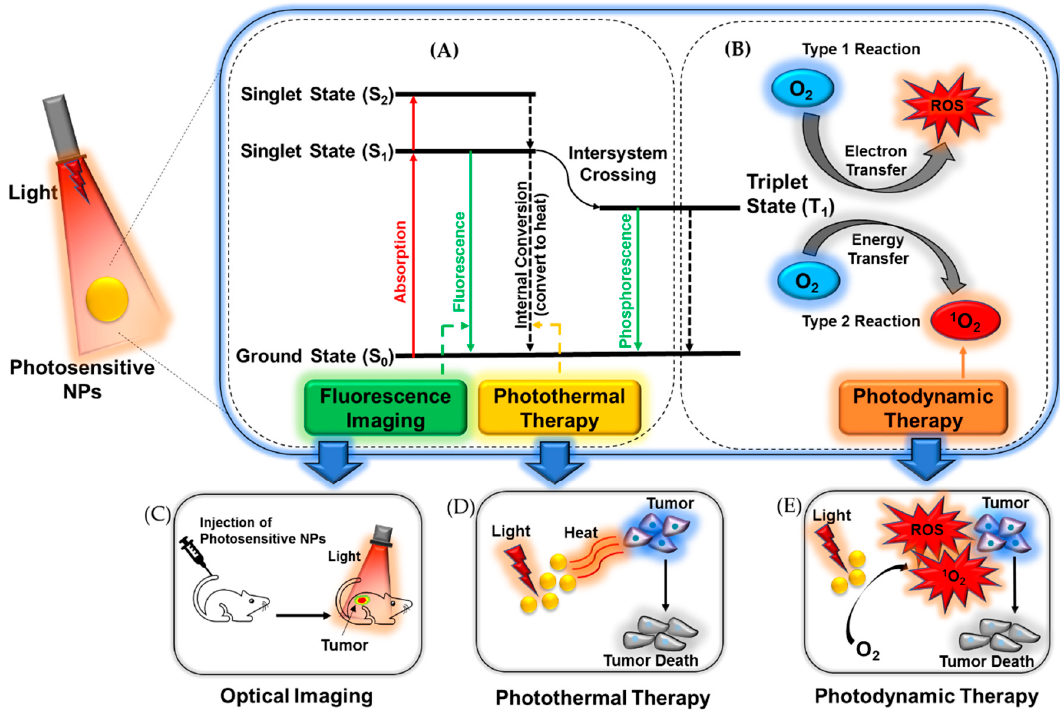
Figure 1. Illustration of the basic mechanism used in ( A ) fluorescence imaging and PTT, and ( B ) PDT and use of photosensitive nanomedicine in ( C ) OI, ( D ) PTT, and ( E ) PDT. NPs: nanoparticles; ROS: reactive oxygen species; PTT: photothermal therapy; PDT: photodynamic therapy; OI: optical imaging.